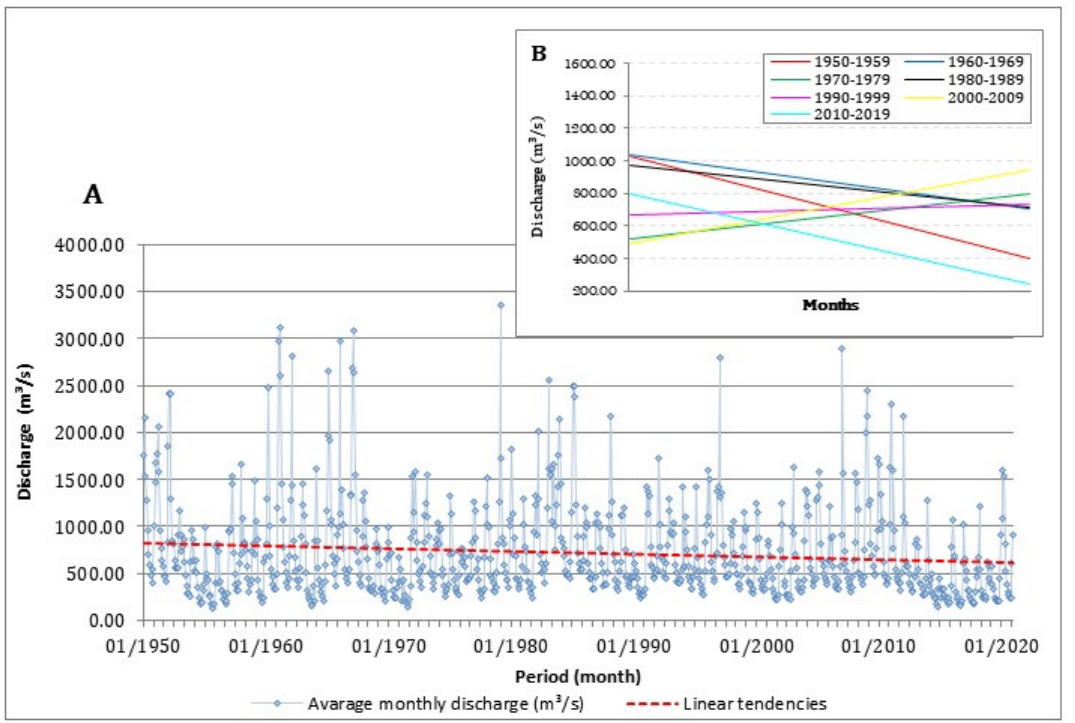
Figure 4. Average monthly discharge in the Paraíba do Sul River. ( A ) Fluvial discharge (m 3 /s) from 1950 to 2020. ( B ) Linear tendencies of discharge on the decadal scale [104].